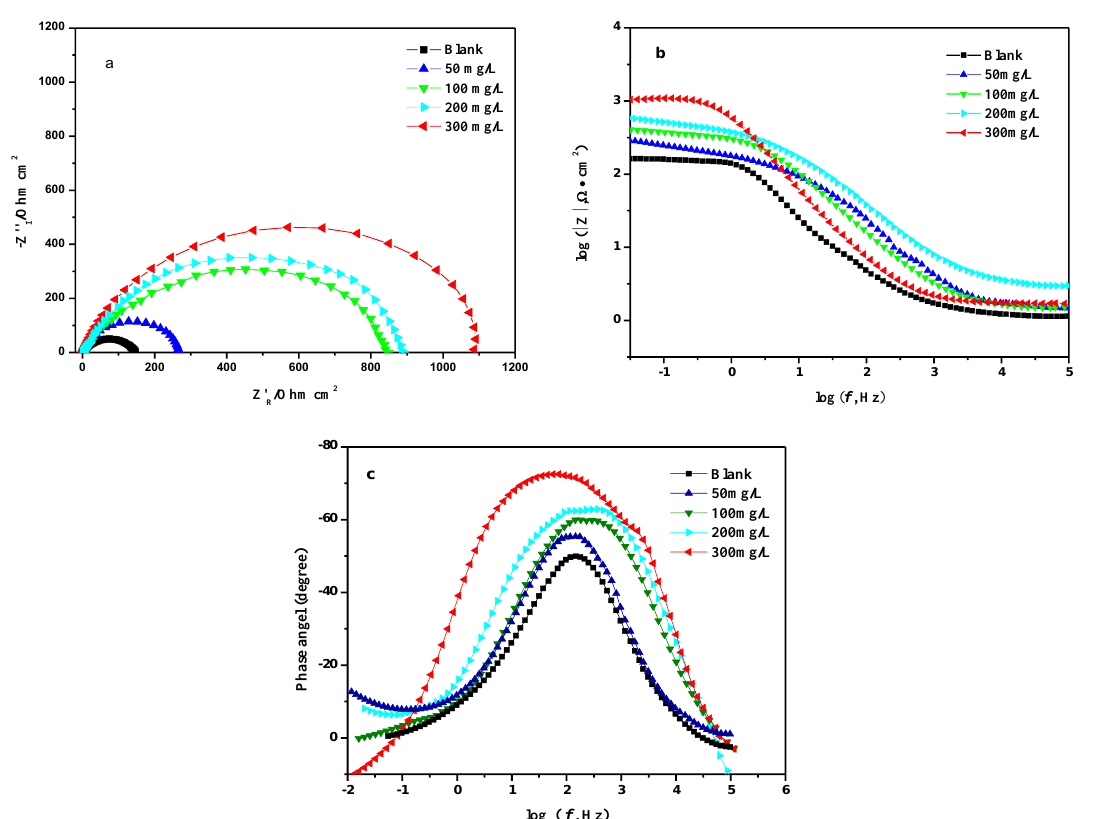
Figure 6. Nyquist ( a ), Bode-modulus ( b ) and Bode-phase angle ( c ) diagrams of N80 steel sheets with different concentrations of MBT.